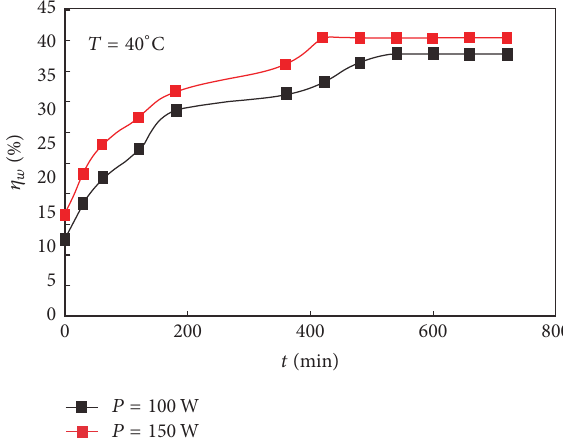
Figure 9: The impact of ultrasonic powers (50 W and 100 W) on sonochemistry dehydration.